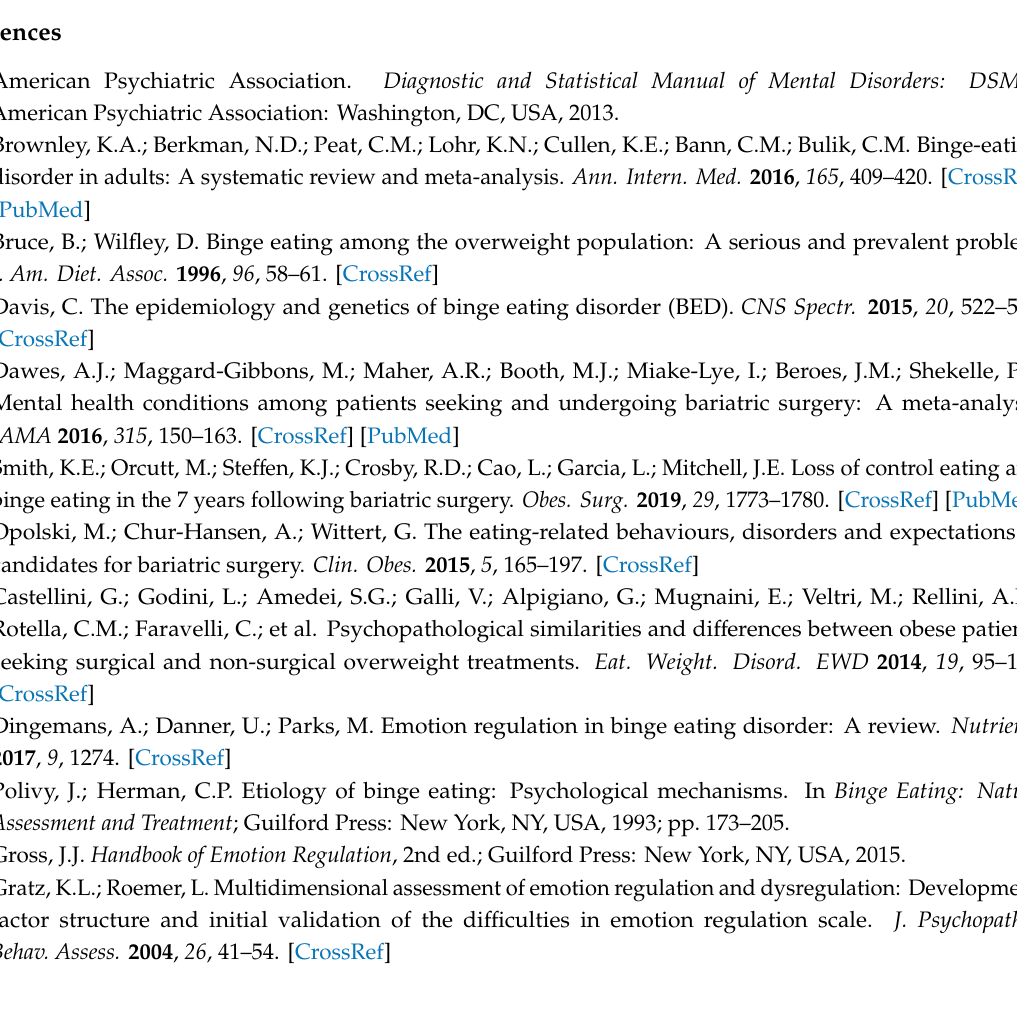
Table S1: Results of regularized-method LASSO with inference, Table S2: Results of regularized-method LASSO with inference, Table S3: Bayesian approach: Population-Level E ff ects